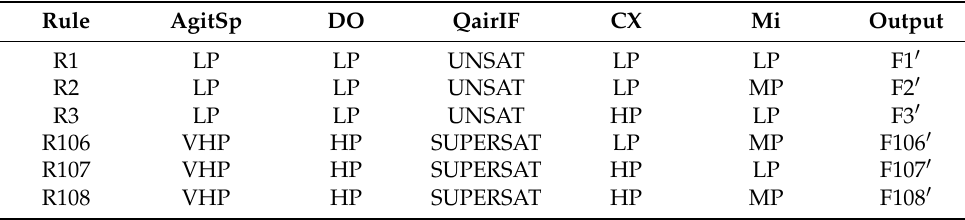
Table 4. Rule table of Princ1 fuzzy system. Princ2 has the same input values, though with different linear output functions.